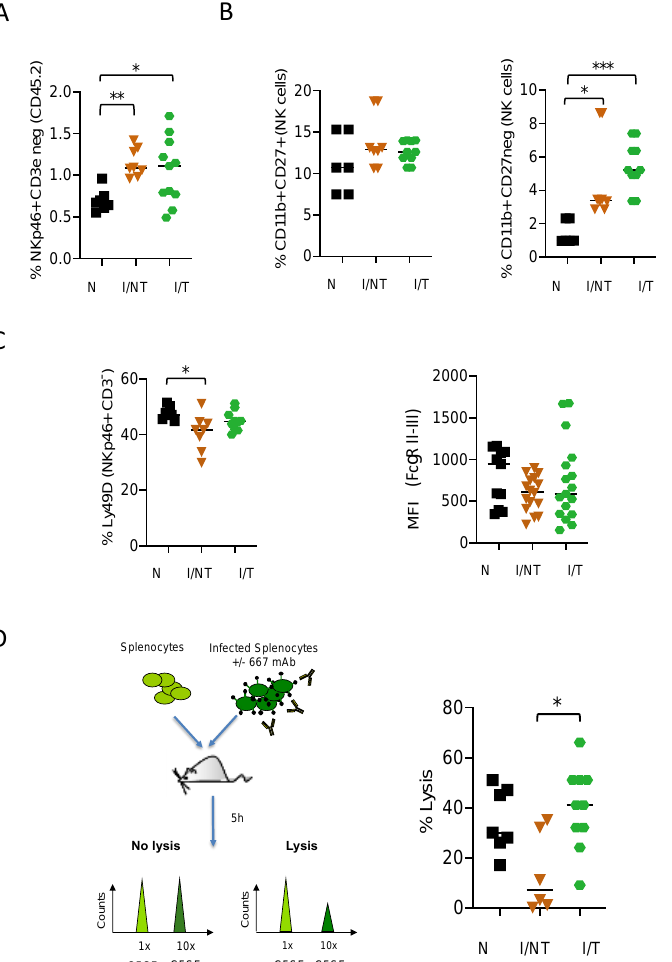
Figure 1. Effect of monoclonal antibody (mAb) treatment of FrCasE-infected mice on NK cell recruitment and functional activation. Eight-day-old pups were infected with the FrCasE retrovirus and treated or not with the 667 mAbs on days 0, 2 and 5 p.i.: ( A ) frequency of CD3 − NKp46 + cells in the CD45.2 + leukocytic population at 14 days p.i.. The data presented correspond to 3 independent experiments with the following number of mice per group: naïve ( N ) ( n = 7); infected/non-treated (I/NT) (n = 8); infected/treated (I/T) ( n = 11); ( B ) maturation state of NK cells assessed by the expression of CD27 and CD11b in the CD3 - NKp46 + population at 14 days p.i. The data presented correspond to 2 inde- pendent experiments with the following number of mice per group: naïve ( n = 5); infected/non- treated ( n = 8); infected/treated ( n = 8); ( C ) assessment of the functional state of NK cells assessed by the expression of cell surface markers involved in the activation (Ly49D) and antibody-dependent cell-mediated cytotoxicity (ADCC) activity (Fc γ Rs) at 14 days p.i. The data presented correspond to 3 independent experiments with the following number of mice per group: naïve ( n = 7); in- fected/non-treated ( n = 8); infected/treated ( n = 10) for Ly49D and 4 independent experiments with